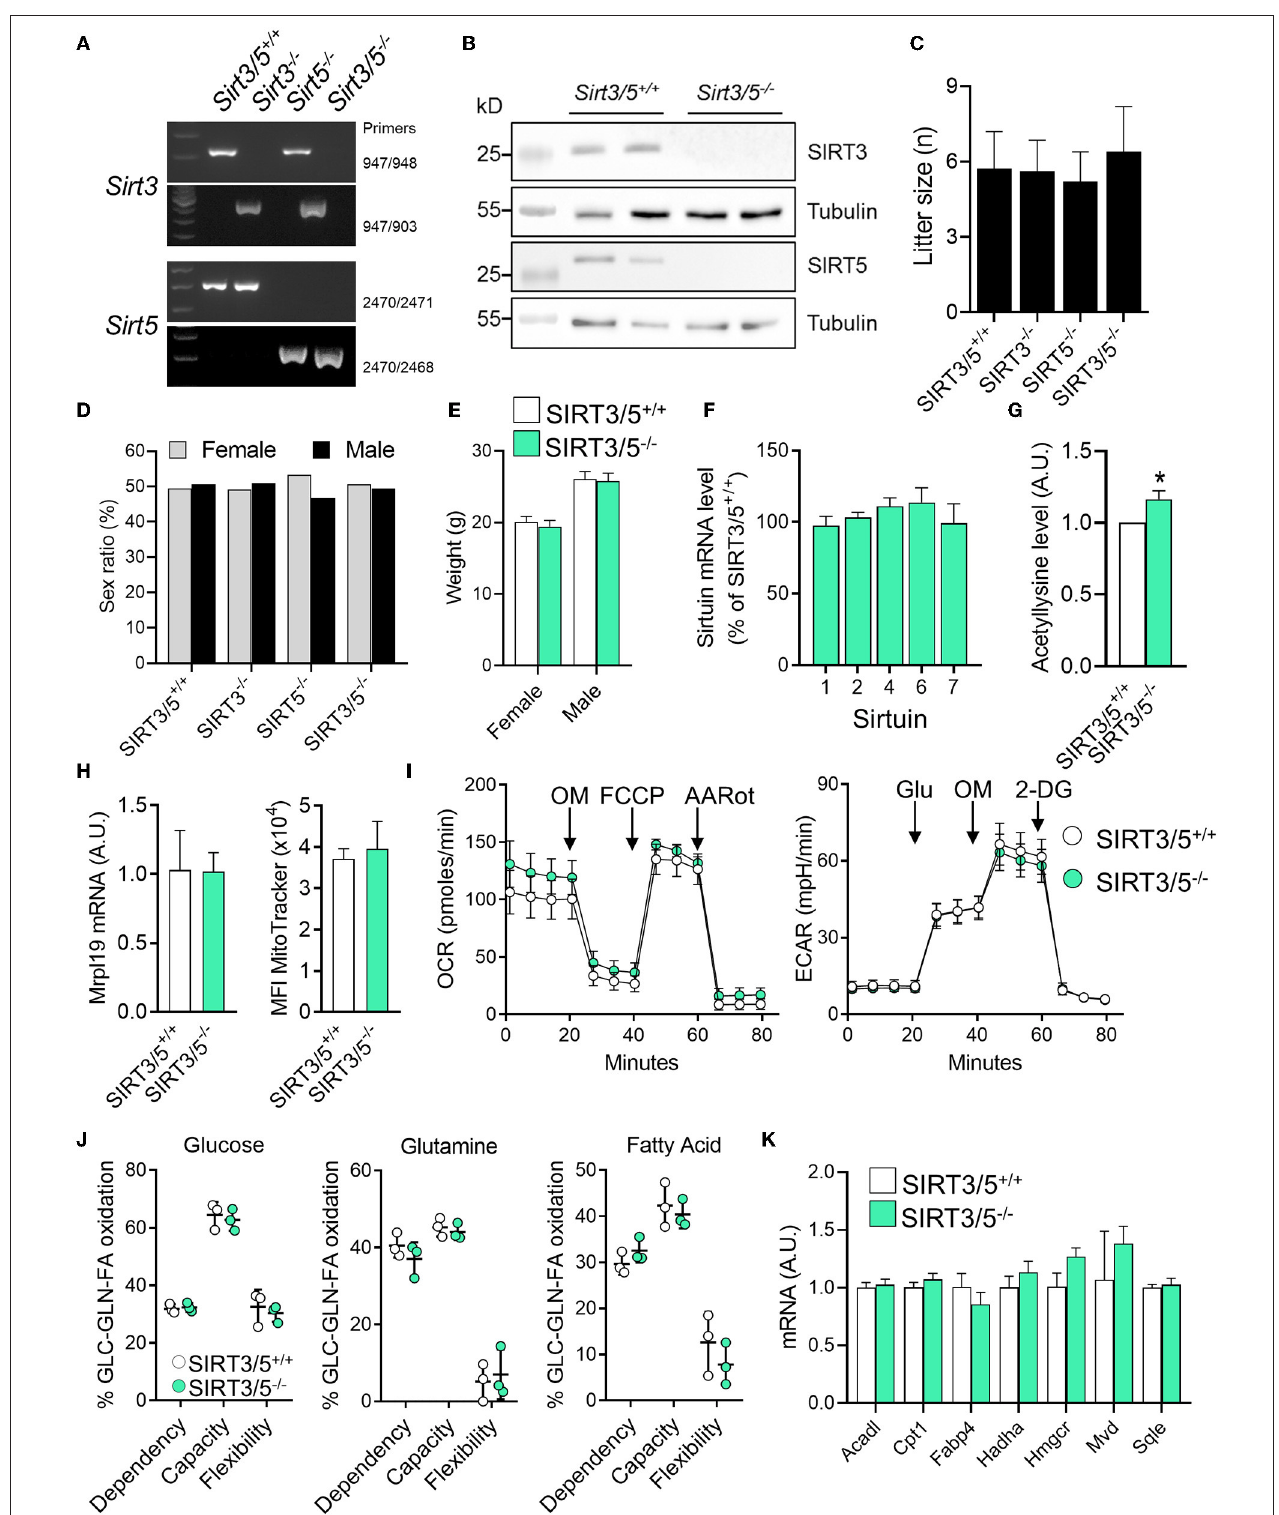
FIGURE 1 | SIRT3/5 deficiency has no evident impact on mouse development and macrophage metabolism. (A) Genotyping of SIRT3/5 + / + , SIRT3 − / − , SIRT5 − / − , and SIRT3/5 − / − mice by PCR. Genomic DNA was amplified by PCR using the primer pairs indicated on the right and reaction mixtures were electrophoresed through